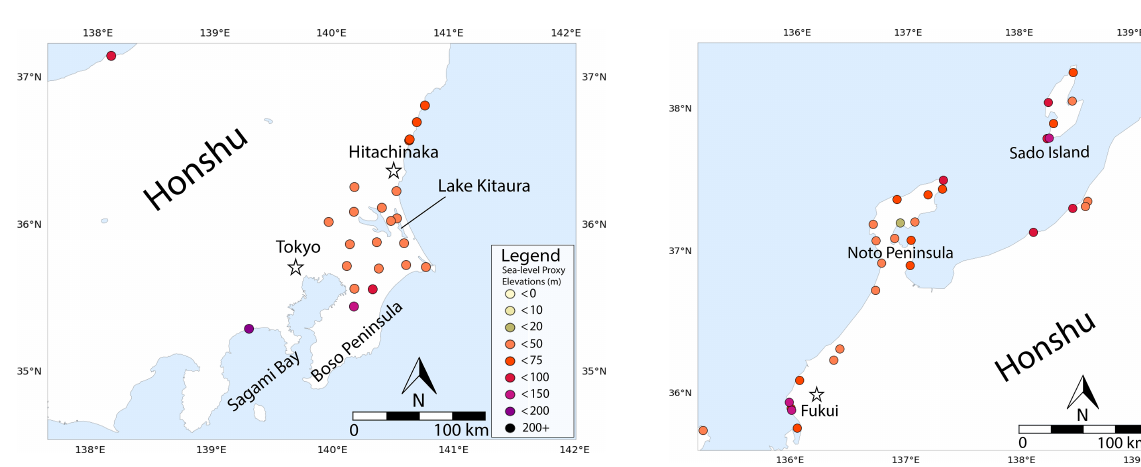
Figure 7. Sea-level elevation around the Noto Peninsula. Sea-level indicators (circles) with elevation range indicated by color (see leg- end). Reference cities are indicated by